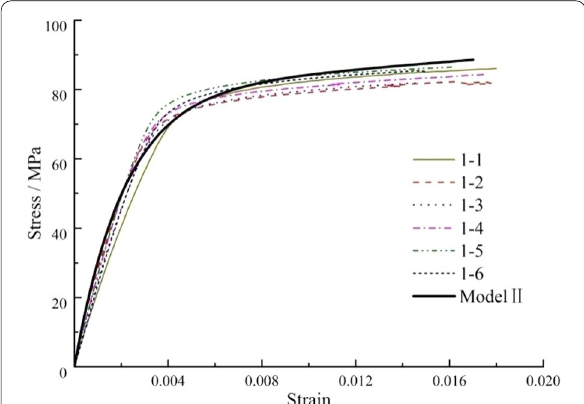
Fig. 7 Comparison of the exponential model and experimental results